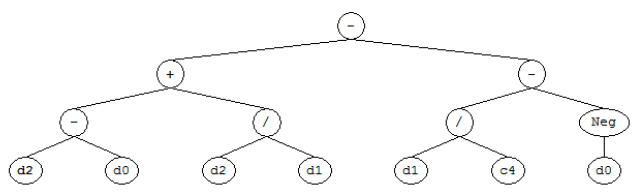
Figure 8. The first sub gene-expression tree.